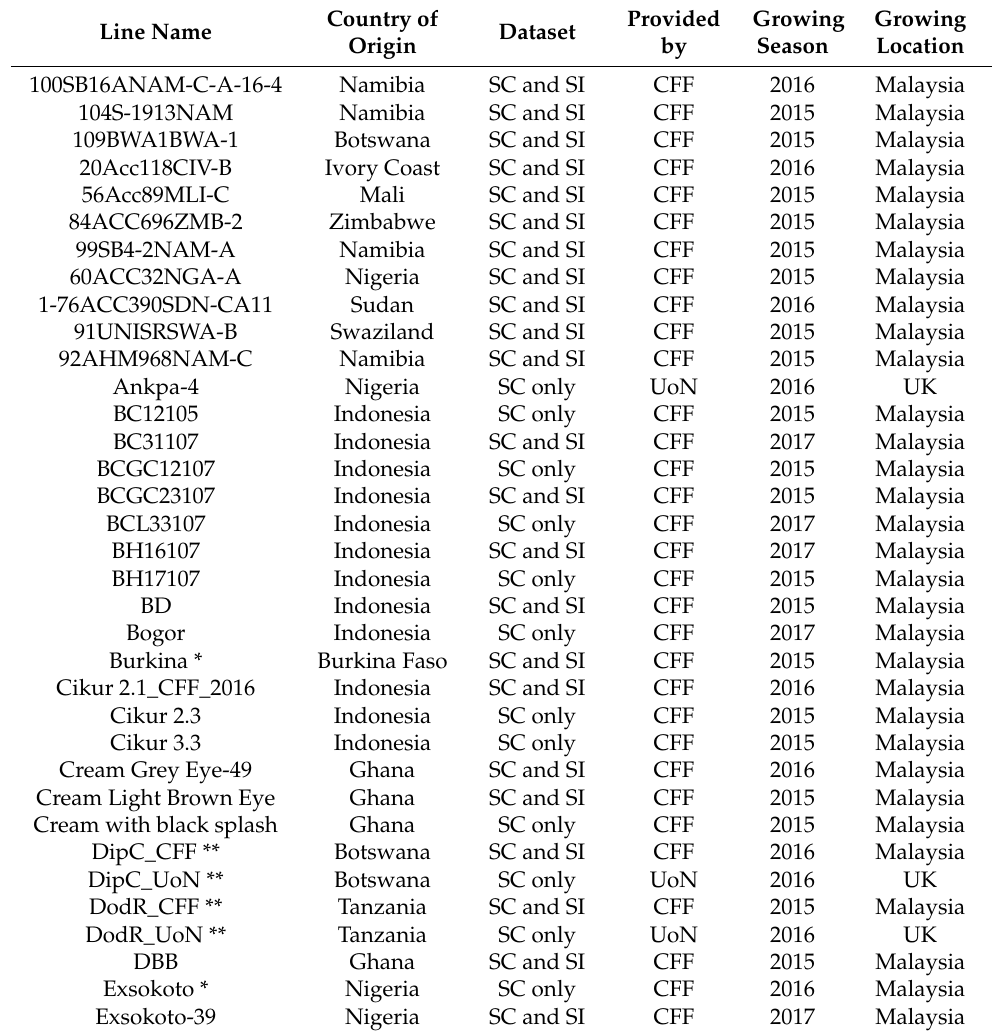
Table 1. List of bambara groundnut lines used to construct global diversity dataset for de novo analysis of seed proximate composition (indicated with SC), and subset of 40 lines used for de- velopment of selection indices (indicated with SI). Lines labelled with asterisk (*) were used for broad-sense heritability estimation using parent-offspring regression. Lines labelled with double as- terisks (**) were used for broad-sense heritability estimation using multi-locational (GxE) interaction. DBB = dotted brown/black eye, LBLBE = light brown/light brown